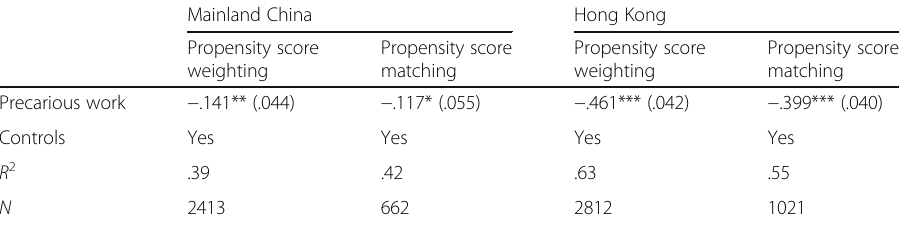
Table 4 Wage differential between precarious workers and non-precarious workers in mainland China and Hong Kong (propensity score analysis)